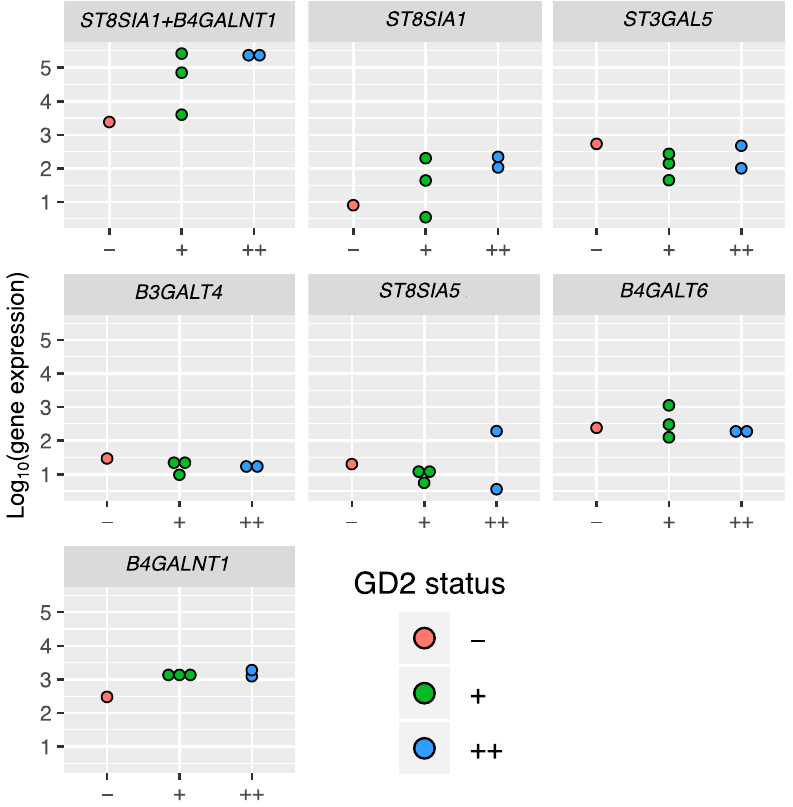
Figure 3. Expression of GD2 biosynthesis enzyme genes in cell lines with different GD2 status. Each panel, except ST8SIA1 + B4GALNT1 , corresponds to a single gene and contains log10-transformed normalized gene expression values for cell lines of three GD2 phenotypic groups (GD2 ++ , GD2 + , and GD2 − ). The panel ‘ ST8SIA1 + B4GALNT1 ’ represents gene signature scores calculated as sum of log10-transformed gene expression values of genes ST8SIA1 and B4GALNT1 .